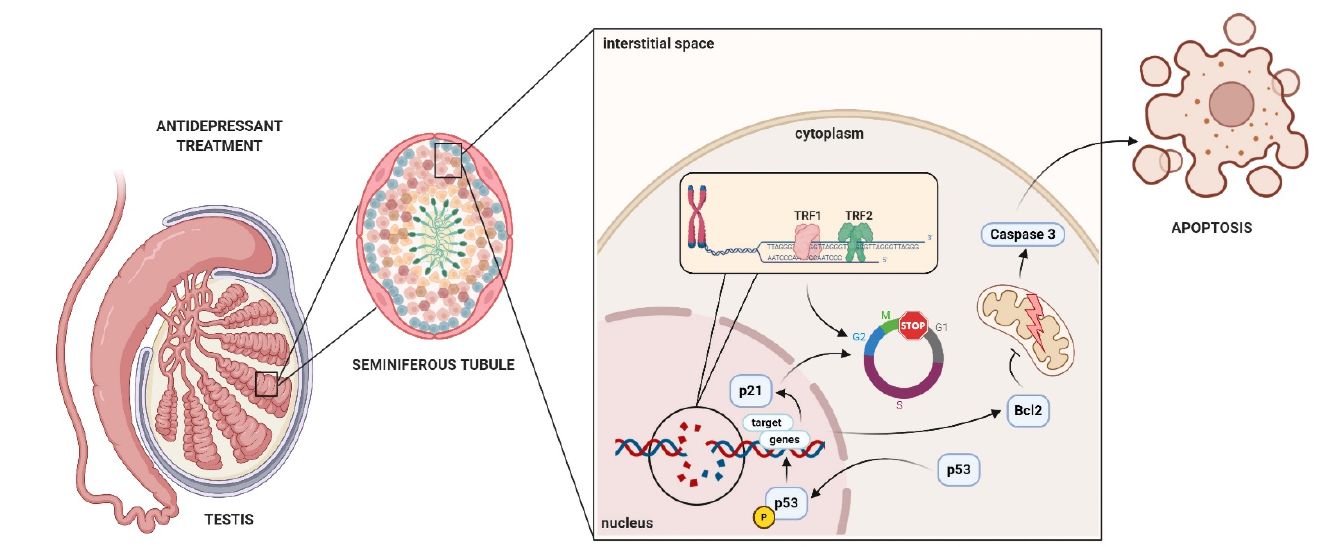
Figure 8. A potential mechanism for antidepressants-induced reprotoxic side effects. The antidepressant and neuroleptic drugs treatment induce the genotoxic events and adaptation mechanisms in GC-1 spg and GC-2 spd cells.